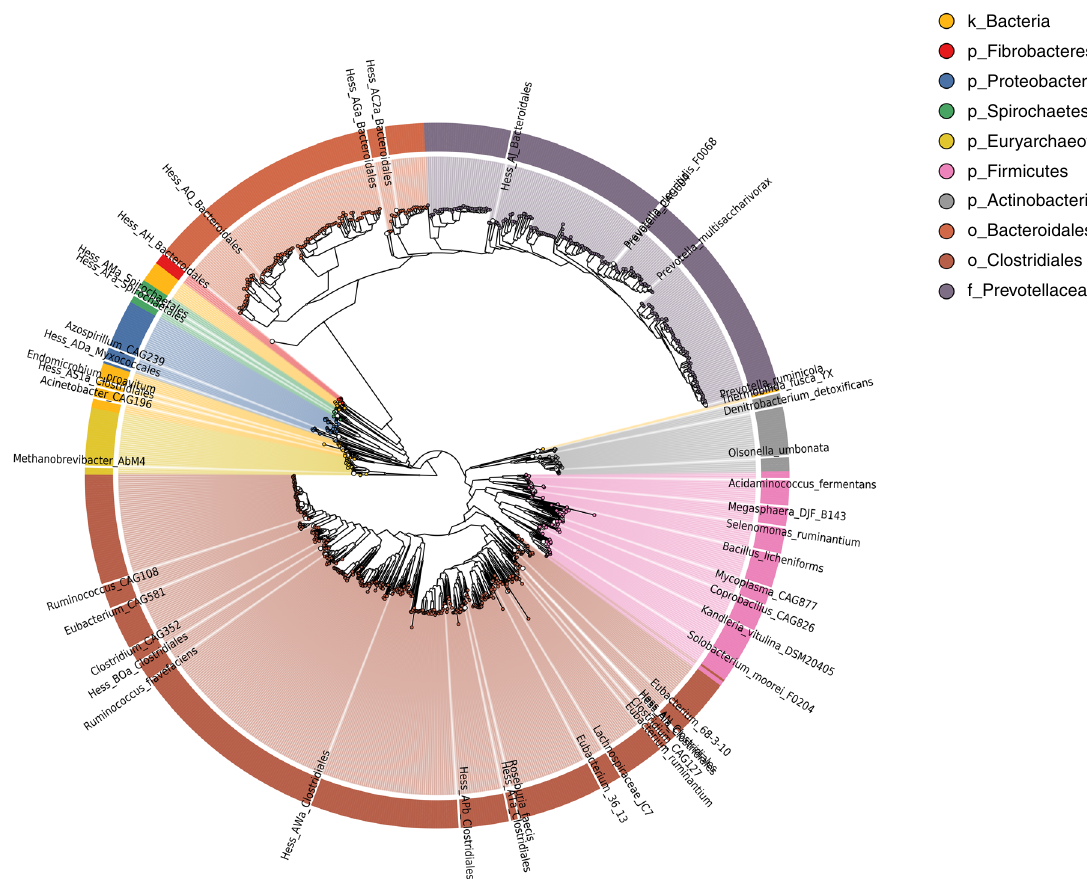
Fig. 1 Phylogenetic tree of 913 draft genomes from the cow rumen, and closely related public genomes including 15 binned genomes from Hess et al 1 . Coloured circles represent the RUGs. White circles represent public genomes and have corresponding